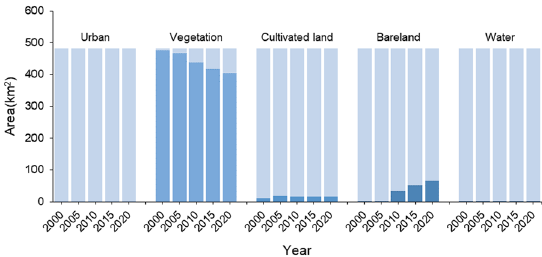
Fig. 4 Area affected by various LUCC changes from 2000 to 2020